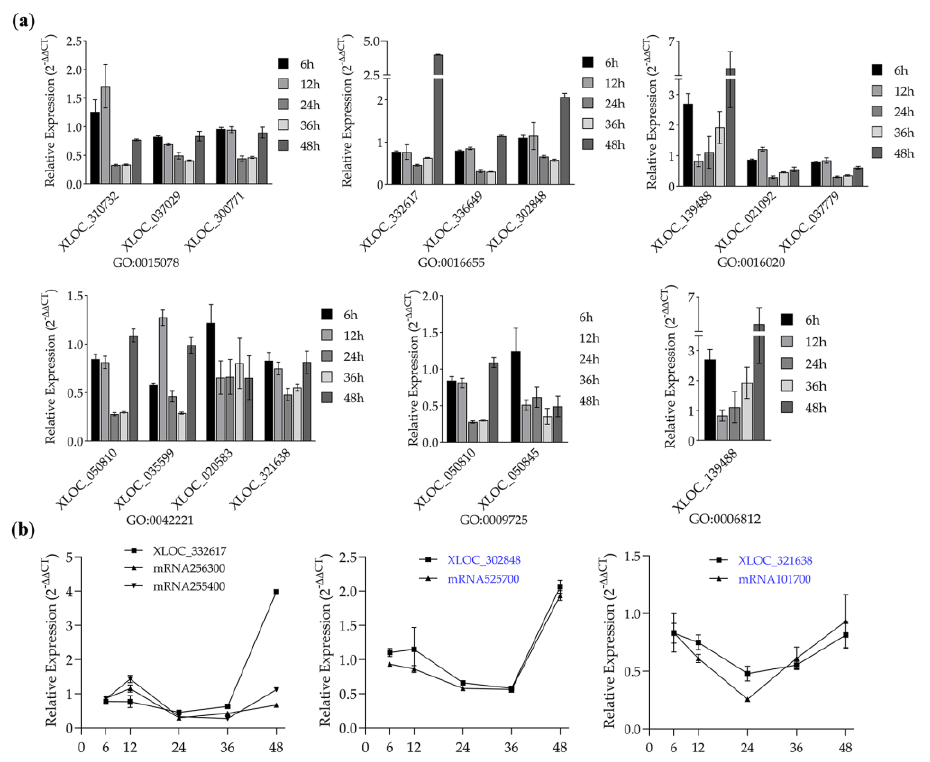
Figure 7. Validation of the defense expression profiles of lncRNAs and expression patterns of lncRNAs coupled with their target genes by using quantitative RT-PCR. ( a ) Defense expression profiles of lncRNAs from six F. graminearum -responsive GO terms. Legend, di ff erent time points after inoculation with F. graminearum . ( b ) Expression pattern of lncRNA-putative target gene pairs after inoculation with F. graminearum . X -axis, di ff erent time points after inoculation with F. graminearum . The 2 – ∆∆ CT method was used to calculate the expression level of lncRNAs and putative target genes. Actin was chosen as the reference gene. Data represent means ± standard deviation (SD) of three replicates.